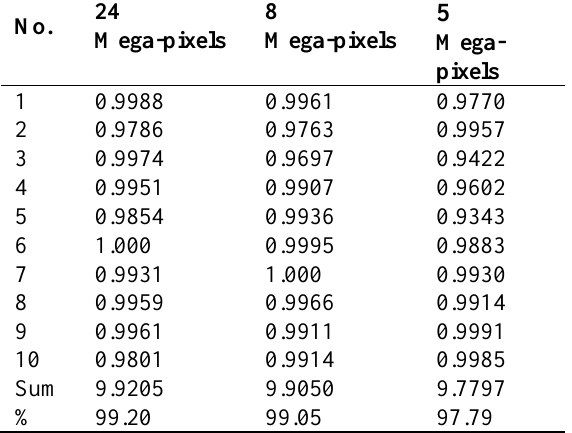
Illustrates the model evaluation